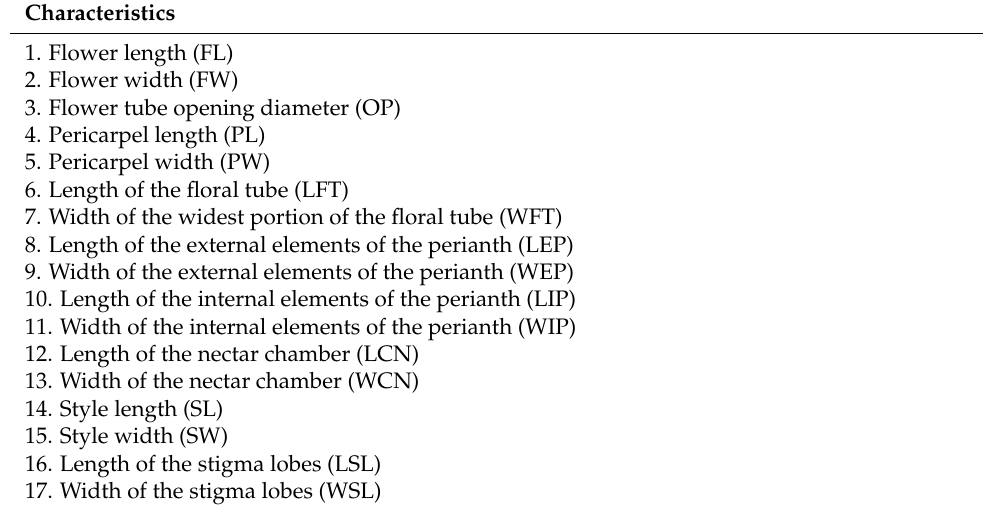
Table 2. Quantitative floral morphological characteristics measured of flowers of Cereinae (Cereeae- Cactaceae) species pollinated by